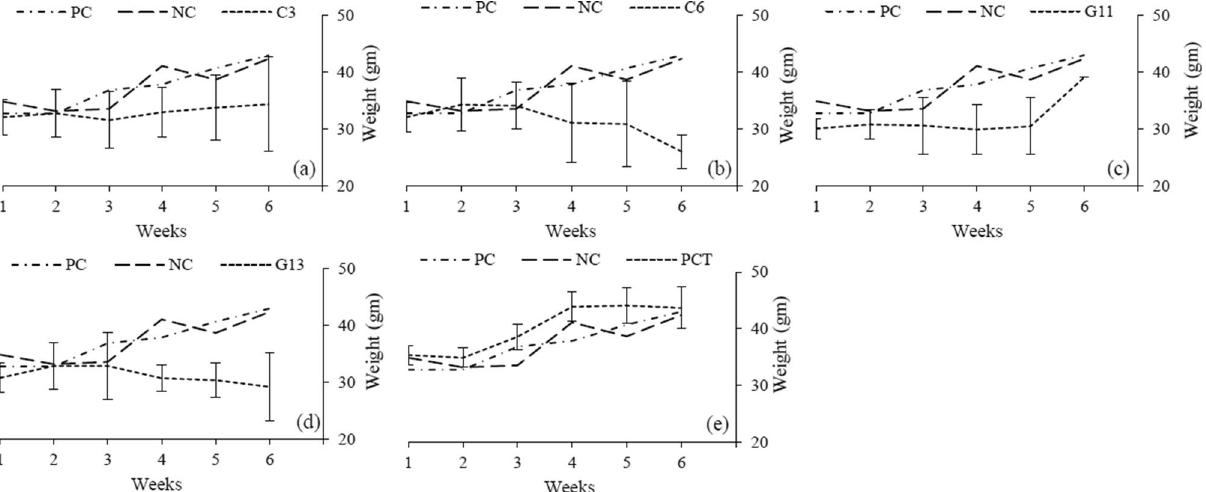
Figure 5. Body weight of the mice among different probiotic groups compared to positive and negative control groups. The vertical lines indicated the standard deviation from the mean